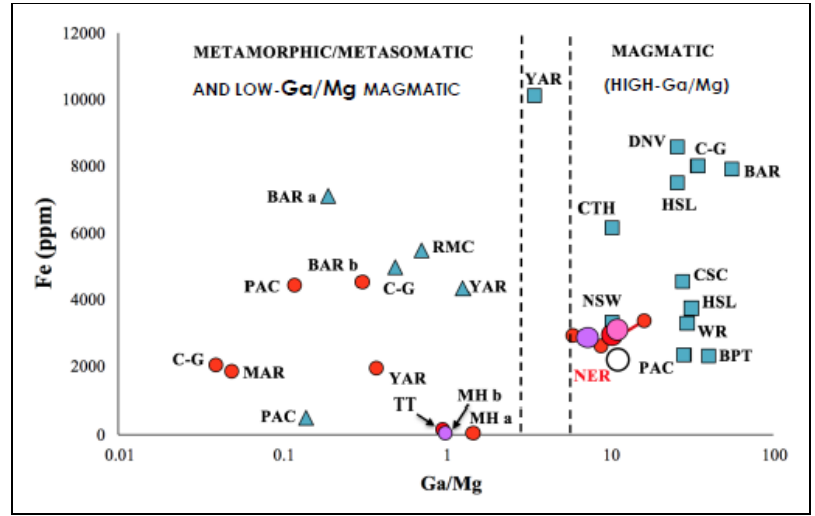
Figure 19. Fe-Ga/Mg diagram after [55], showing averaged plots from selected examples of ruby and sapphire suites from East Asian, East Australian and other localities, from data after [9,11,59,72]. Short dash lines mark a transitional zone (Ga/Mg 3–6) for Metamorphic/Magmatic fields [66]. Symbols include: Red-filled circles, ruby; Red-violet-white filled circles, zoned ruby-sapphire suites; Blue-filled triangles, low-Ga meta-sapphire suites; Blue-filled squares, higher-Ga sapphire suites. East Asian locality identity letters include: BT, Bo Phloi, Thailand, sapphire; CTH, Chanthanburi, Thailand sapphire; CSC, Changle, Shadong, China, sapphire; DNV, Dak Nong, Vietnam sapphire; MH, Mong Hsu, Myanmar; zoned ruby-sapphire suite; PAC, Pailin (west), Cambodia, ruby and sapphire suites; TT, Thurein Taung, Myanmar, ruby suite. East Australian locality identity letters are: BAR, Barrington Tops, magmatic sapphire, (a) meta-sapphire (b) ruby; C-G, Cudgegong-Gulgong, ruby, sapphire; MAR, Macquarie River, ruby, meta-sapphire, high-Ga sapphire; NSW, New South Wales, high-Ga sapphire; NER, New England, zoned ruby-sapphire; YAR, Yarrowitch, ruby, meta-sapphire, transitional sapphire, WR, Weld River, Tasmania, high Ga-sapphire. Other: RMC, River Mayo, Colombia, South America sapphire.